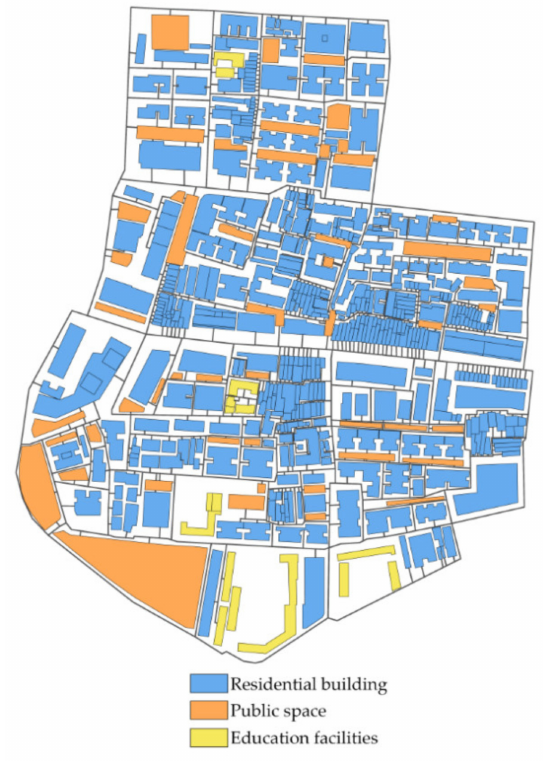
Figure 4. The distribution of buildings and public areas.